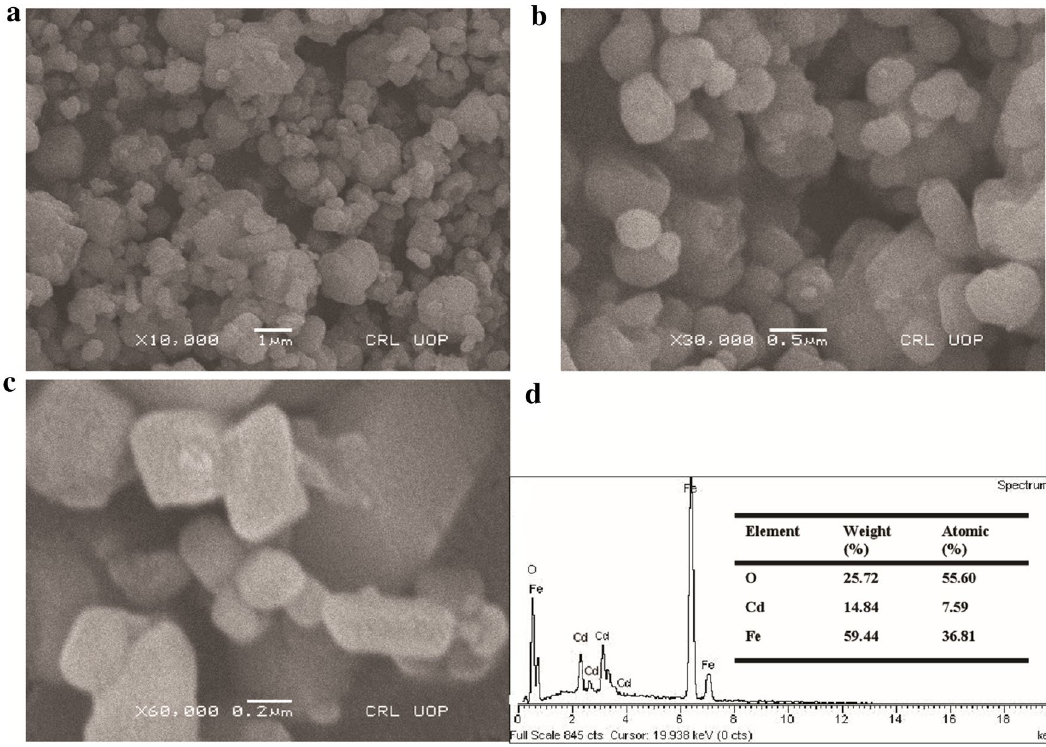
Figure 1. ( a ) FESEM image of CdFe 2 O 4 (low magnification). ( b , c ) high magnification FESEM image. ( d ) XEDS spectrum of CdFe